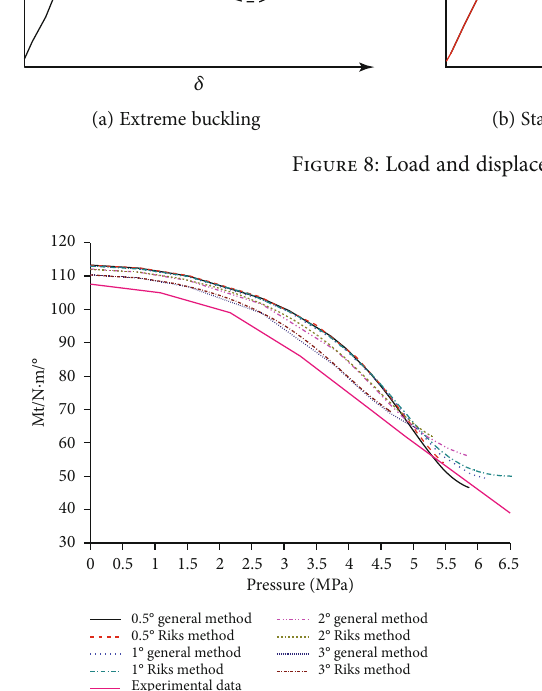
Figure 9: The spring torque changes with the